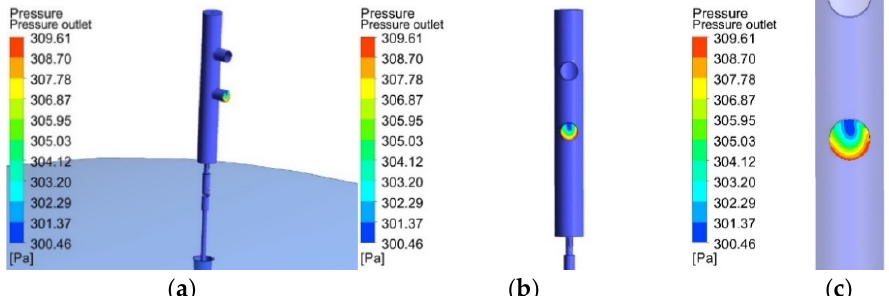
Figure 10. Pressure location, high-pressure section: ( a ) Isometric view, ( b ) Front view, ( c ) location pressure outlet (zoom).